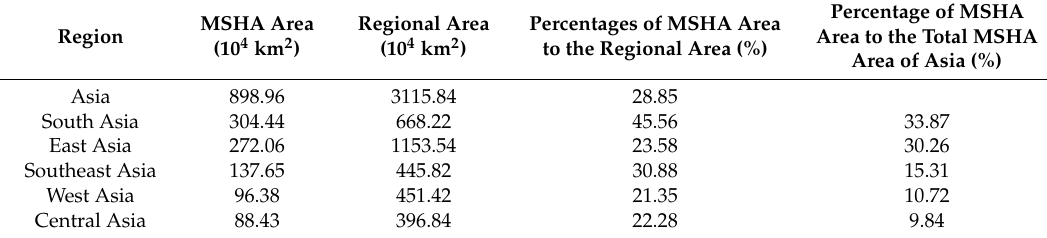
Table 1. The area of